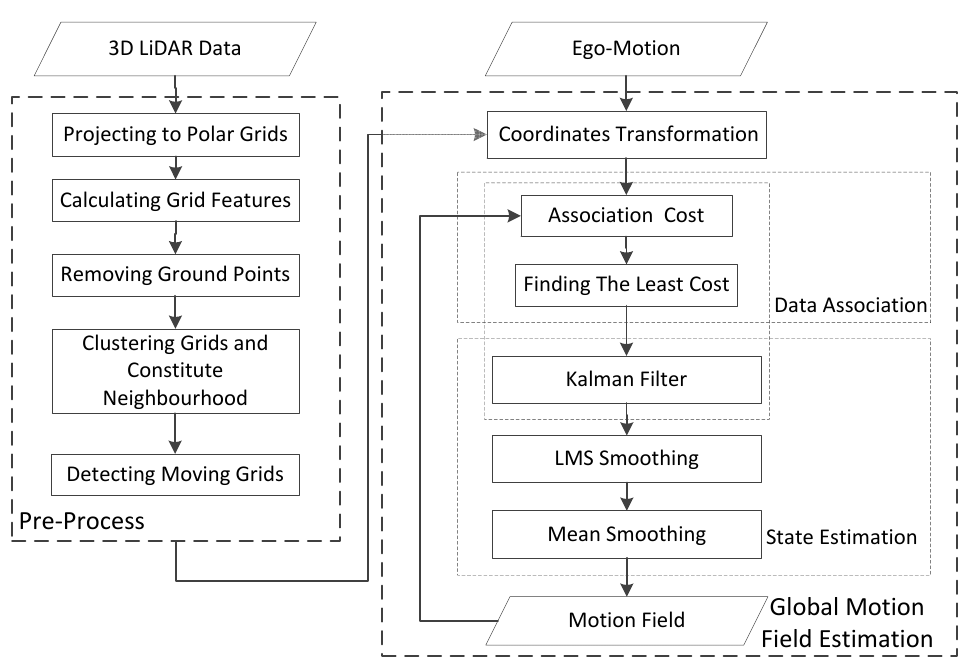
Figure 1. The overall algorithm